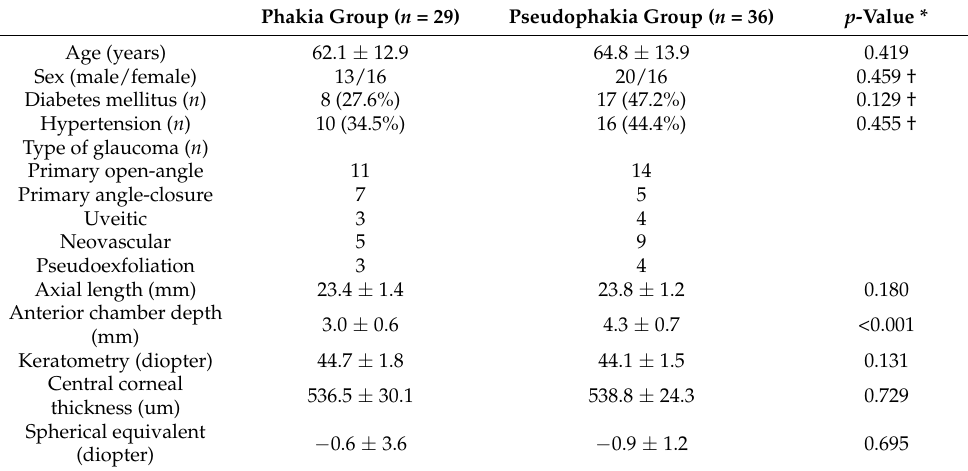
Table 1. Demographic characteristics of patients.